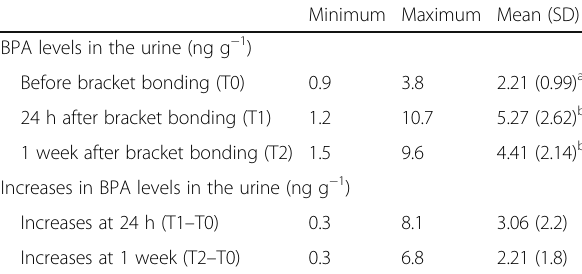
Table 2 BPA levels in urine